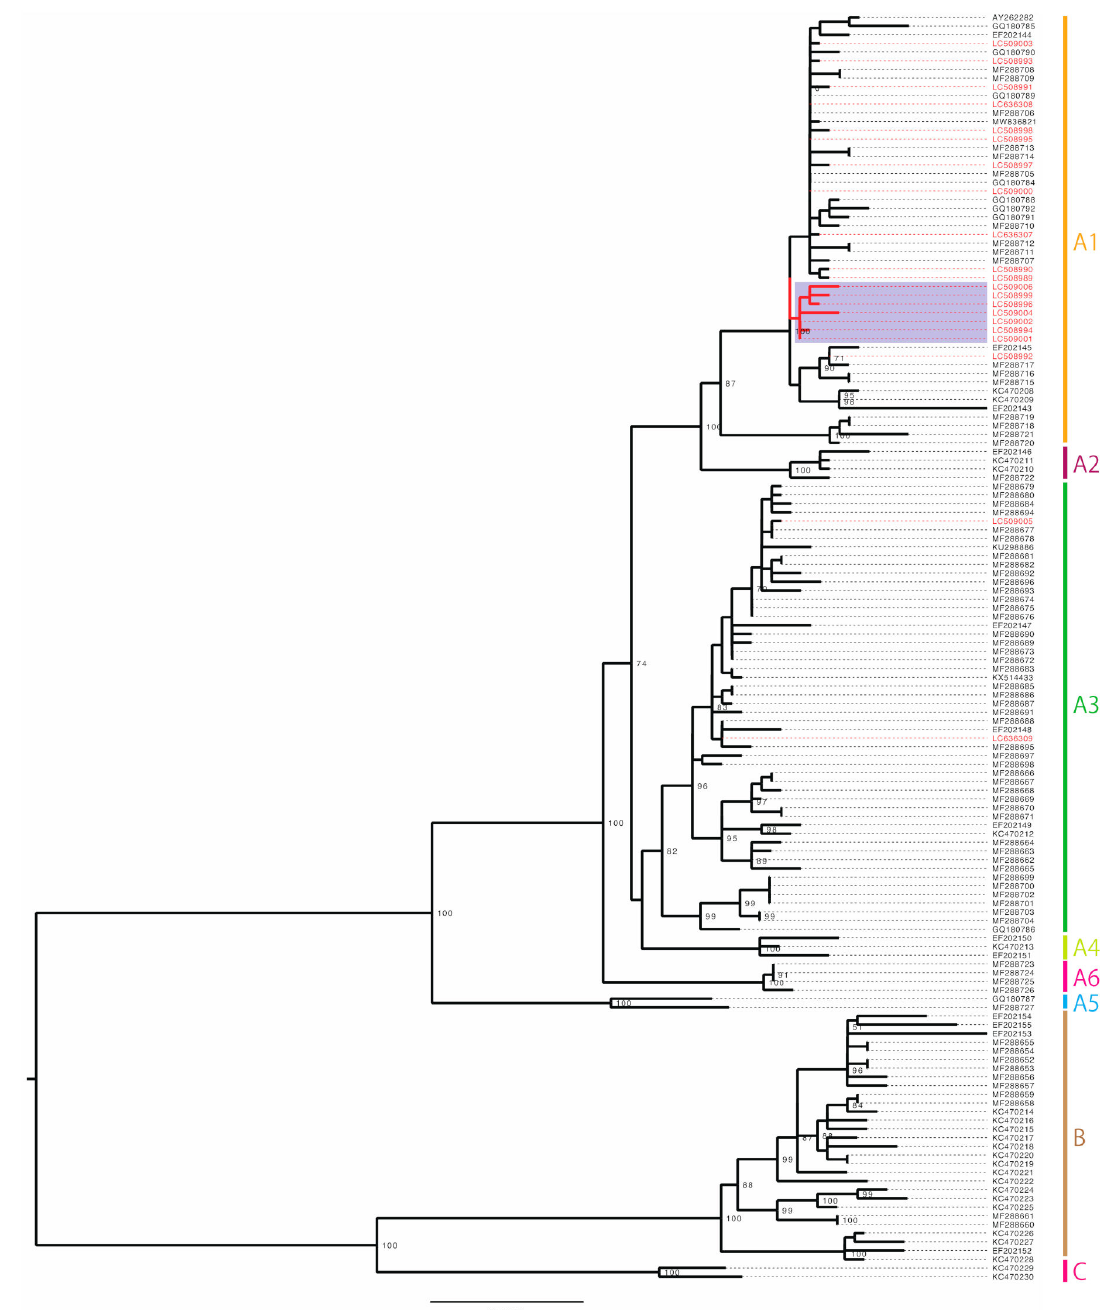
Figure 2. Maximum likelihood phylogenetic tree of complete HPV18 genomes available from Gen- Bank (https://www.ncbi.nlm.nih.gov/genbank/, accessed on 31 August 2021). A total of 146 se- quences were analyzed in RAxML with 1000 bootstrap replicates. Bootstrap values >70% are dis- played. Red taxa indicate 21 sequences from Japan. Purple area marks the Japan-specific cluster of the sublineage A1. Scale bar, nucleotide substitutions per